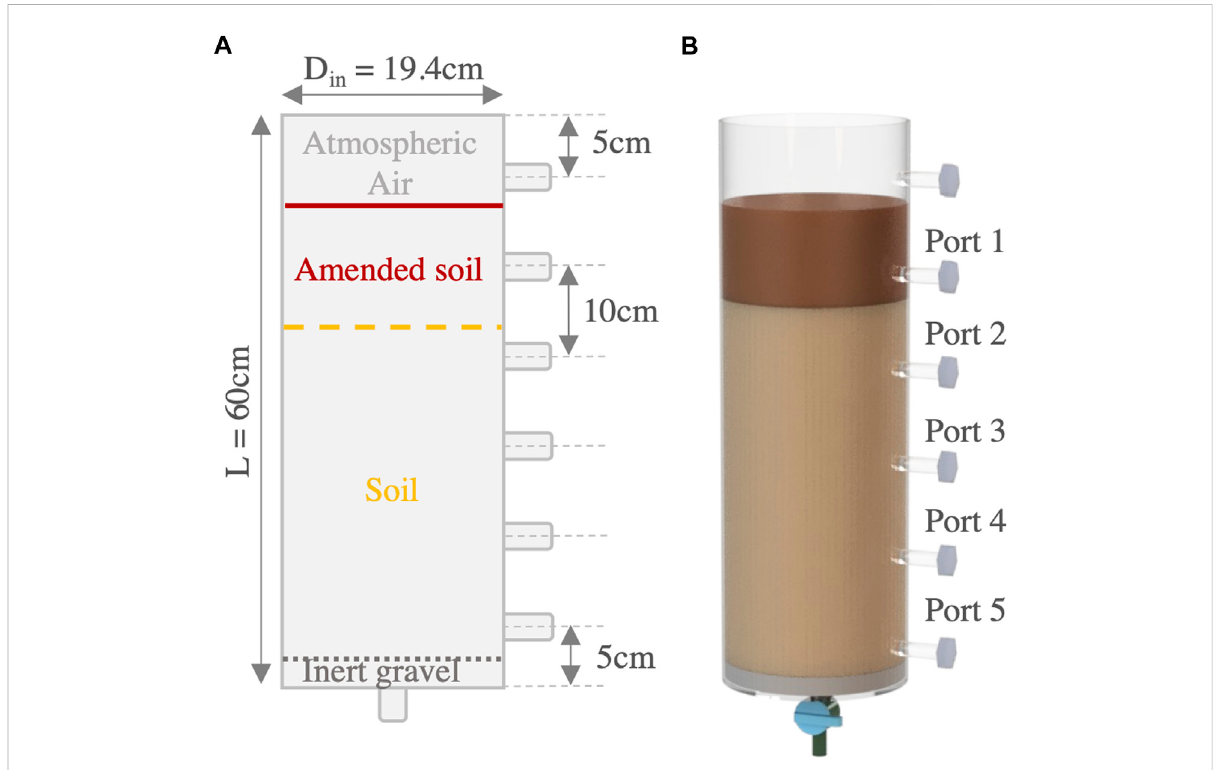
FIGURE 1 (A) Schematic of soilcolumns with column dimensions andpacking layers; (B) 3Drepresentation ofsoilcolumnwith indication ofthedigestate amended soil layer (dark brown) and the soil layers (light